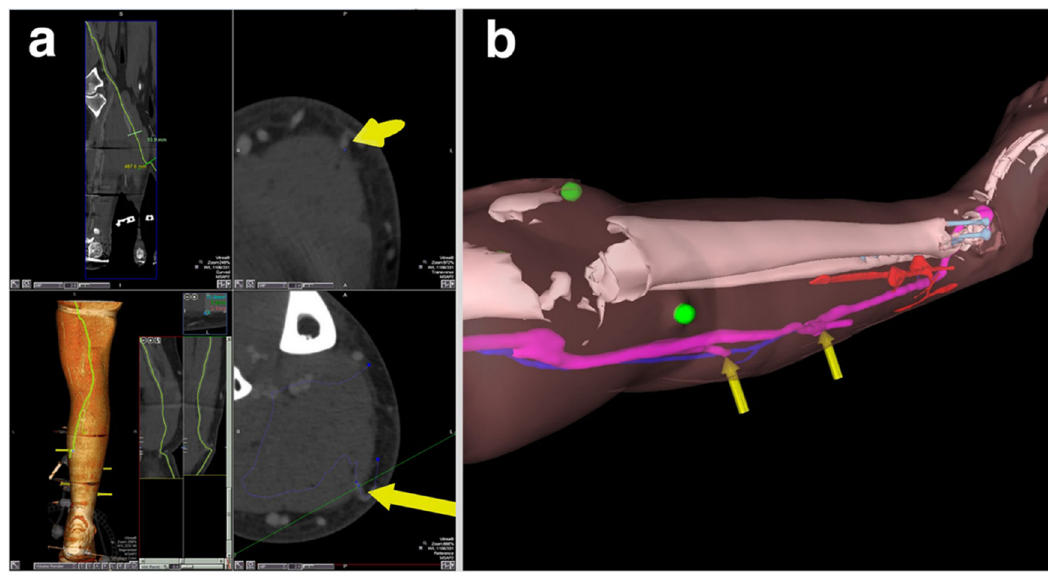
Figure 3. Original CTA imaging, segmentation and corresponding polygonal models. ( a ) CTA imaging indicating the location of the perforating arteries with yellow arrows. ( b ) Example of a HoloLens rendering of the segmented polygonal models [37].